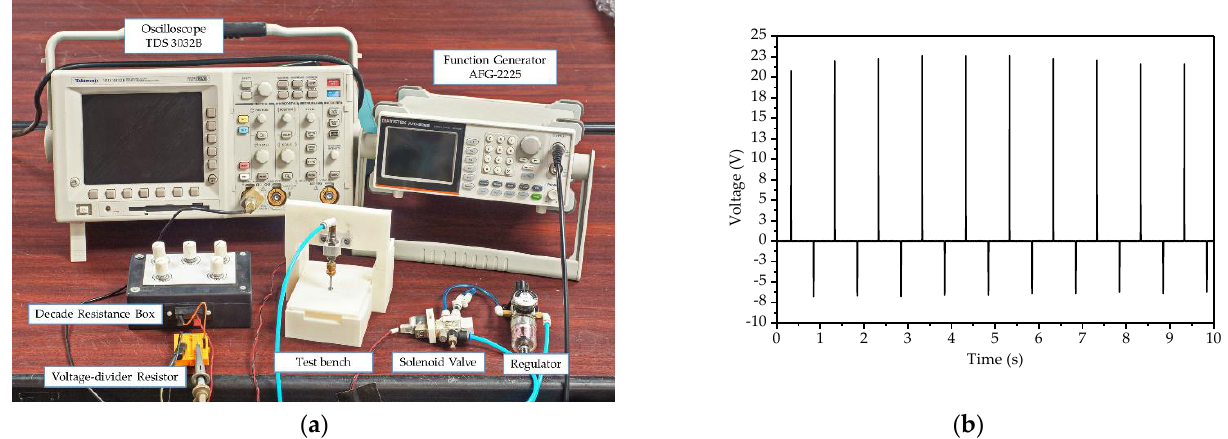
Figure 4. ( a ) Experimental setup test bench; ( b ) voltage signal measured from the developed technique.